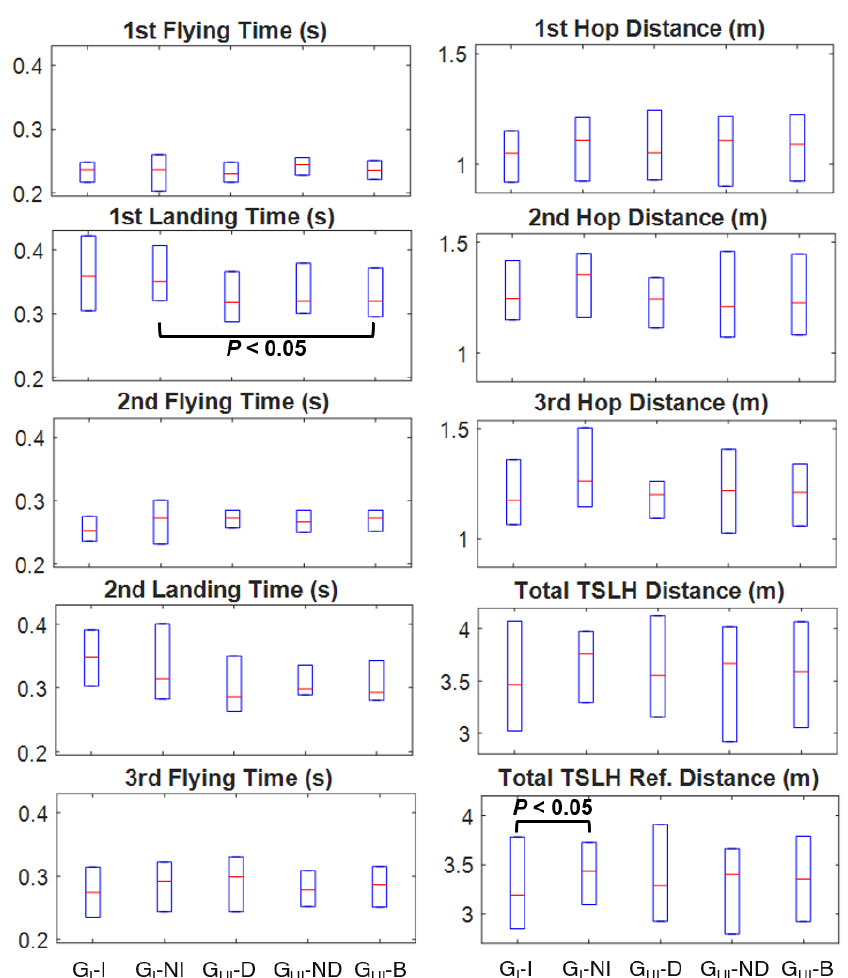
Figure 4. Comparison of temporospatial parameters among all different leg sub-groups of injured (G I ) and uninjured (G UI ) participants. Temporospatial parameters were estimated with IMUs or measured with a measuring tape (shown as Total TSLH Ref. Distance). Box-plots on the left and right sides represent time- and distance-related parameters, respectively. (Leg sub-groups are shown with G I -I: G I ’s Injured Leg, G I -NI: G I ’s Non-Injured Leg, G UI -D: G UI ’s Dominant Leg, G UI -ND: G UI ’s Non-Dominant Leg and G UI -B: G UI ’s Both